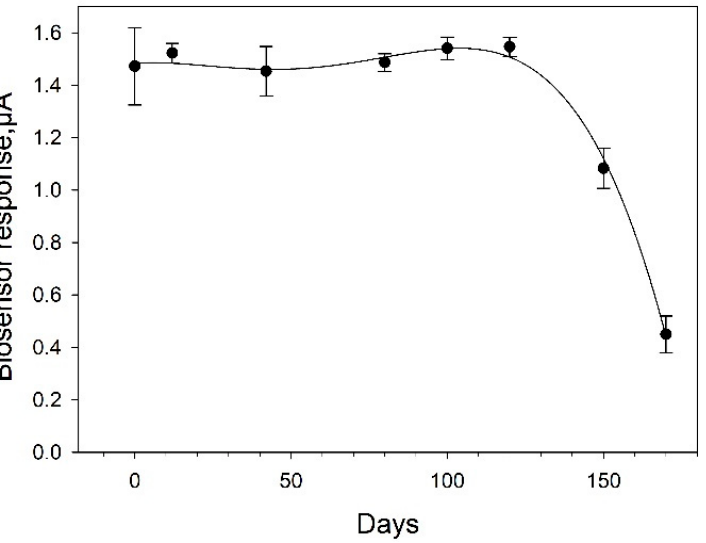
Figure 10. Long-term stability of SPE/PEDOT:PSS/graphene/Nafion/ G. oxydans biosensor. Concen- tration of glucose in the measuring cell, 1 mM.